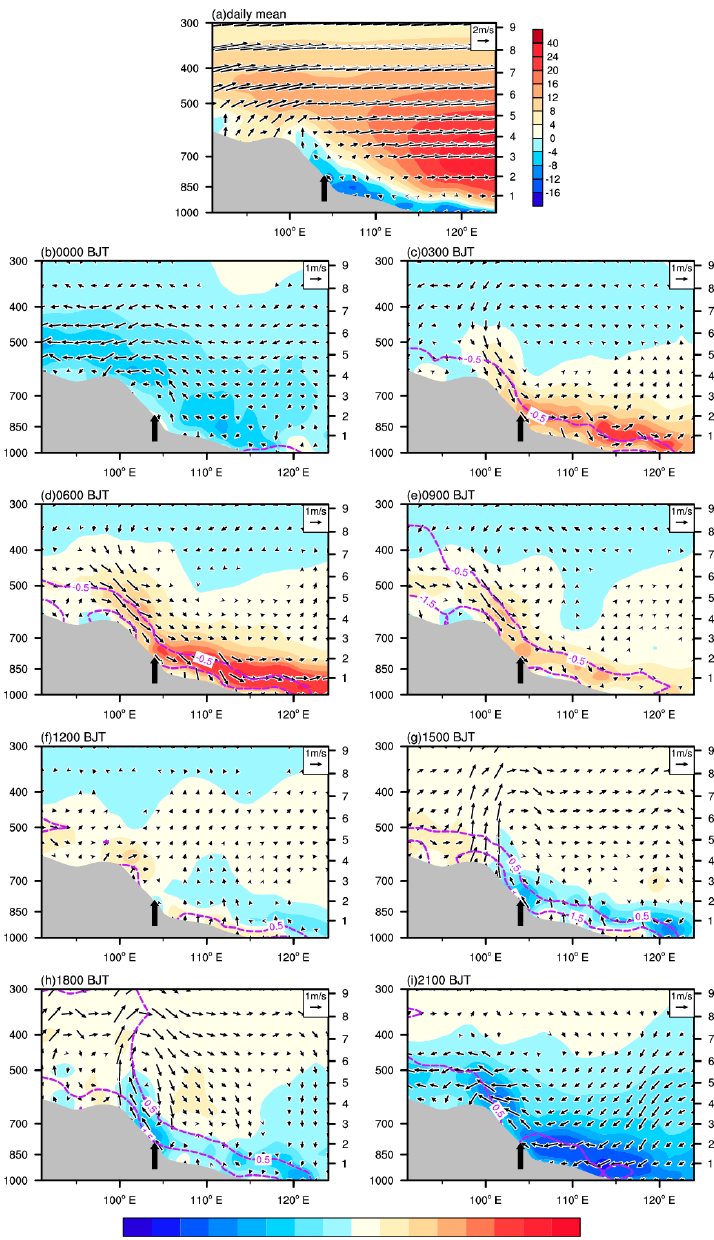
Figure 8. The longitude − height cross-sections of the zonal water vapor transport (shaded; unit: g kg − 1 m s − 1 ) and vertical circulation in summer (vectors; unit: m s − 1 ; the omega has been multiplied by − 20, unit: Pa s − 1 ) along 26° − 39° N. ( a ) is the daily mean; ( b − i ) are the diurnal deviations at 3 h intervals with the daily mean removed. Purple dashed contours denote temperature deviations (units: ◦ C). The gray shaded areas represent the topography. The black upward arrows above the topography indicate the eastern boundary of the